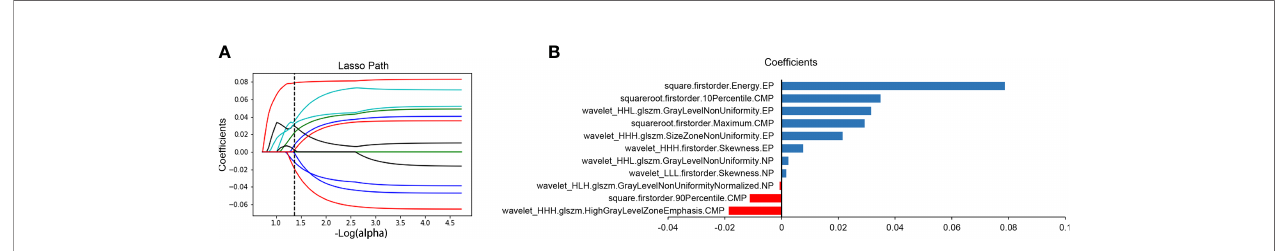
FIGURE 2 | Radiomics feature selection and presentation. Radiomics feature selection using the LASSO Cox regression algorithm. LASSO regression coef fi cient pro fi les of survival-associated radiomics features (A) . A bar chart shows the contribution of selected features for radiomics signature construction (B) . The y-axis represents features that contribute to the signature. The x-axis represents corresponding coef fi cients in the LASSO Cox analysis. LASSO, least absolute shrinkage and selection operator; CMP, corticomedullary phase; NP, nephrographic phase; EP, excretory phase.